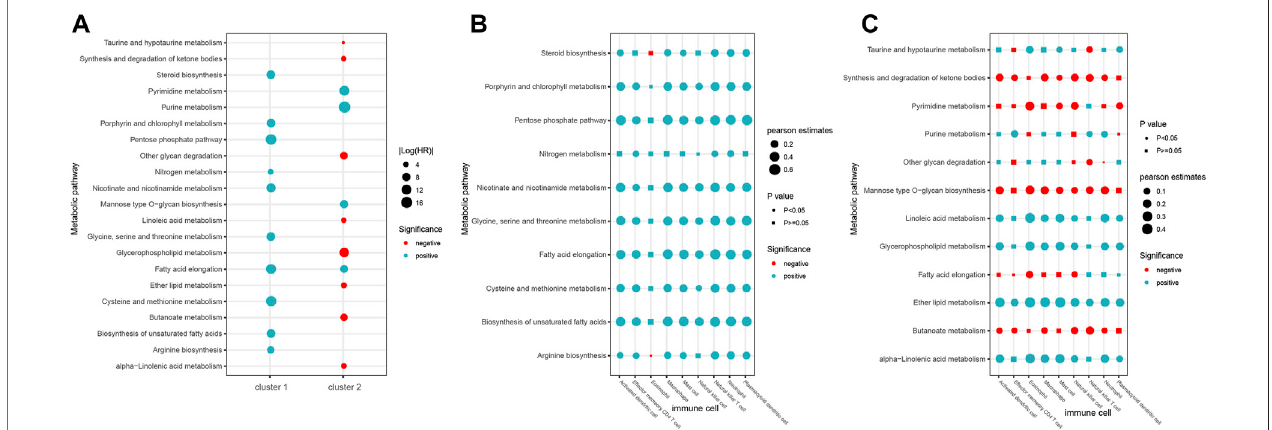
FIGURE 8 | Roles of metabolic pathways in two immune subtypes. (A) Prognosis of metabolic pathways in two immune subtypes. (B – C) Correlation between metabolic pathways and nine immune cells of immune cluster 1 (B) and cluster 2 (C)